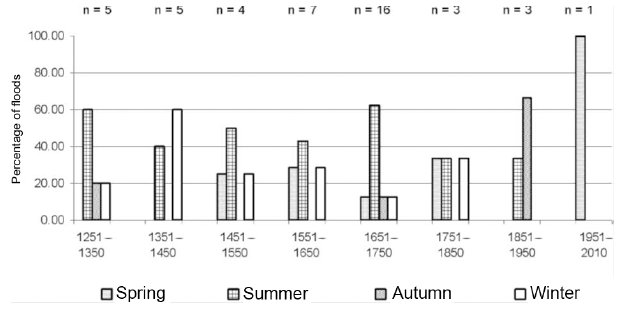
Figure 5. Seasonality of Rhine River flood events for the period 1250–2010 in Basel ≥ 5000m 3 s − 1 (Wetter et al.,